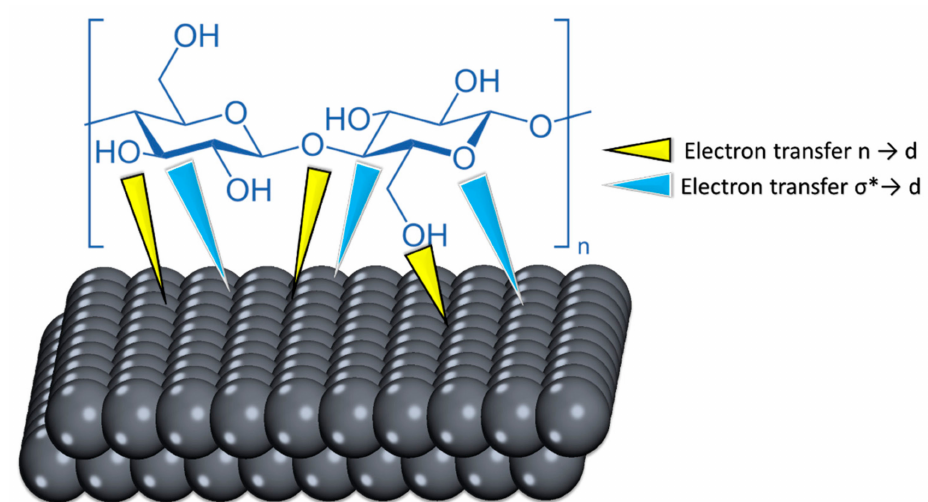
Figure 14. Schematic illustration of the adsorption mechanism of the biopolymer CHA onto mild